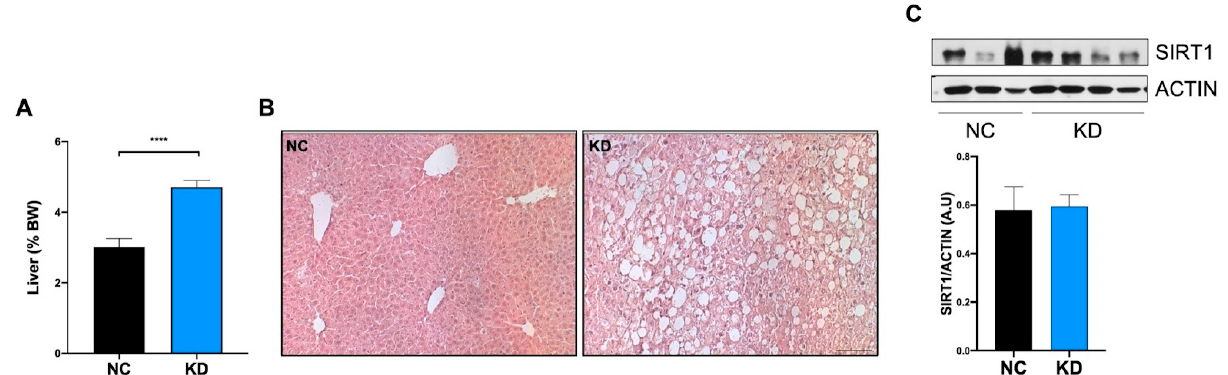
Figure 5. KD treatment effect on liver. ( A ) Analysis of liver coefficient (g liver/g body × 100) of mice under normal chow (NC, n = 6) and ketogenic diet (KD, n = 10) at the end of dietary treatment. Data are expressed as mean ± SEM. **** p < 0.001. ( B ) Representative images of liver morphology by Hematoxylin and Eosin staining on sections obtained from mice under NC and KD at the end of dietary treatment. Magnification 10 × . Scale bar = 50 micron. ( C ) Ketogenic diet effect on liver levels of SIRT1. Western Blotting analysis of SIRT1 expression on liver extracts from mice under normal chow (NC, n = 6) and ketogenic diet (KD, n = 10) at the end of dietary treatment. Densitometric analyses show protein expression levels expressed as arbitrary units ± SEM.